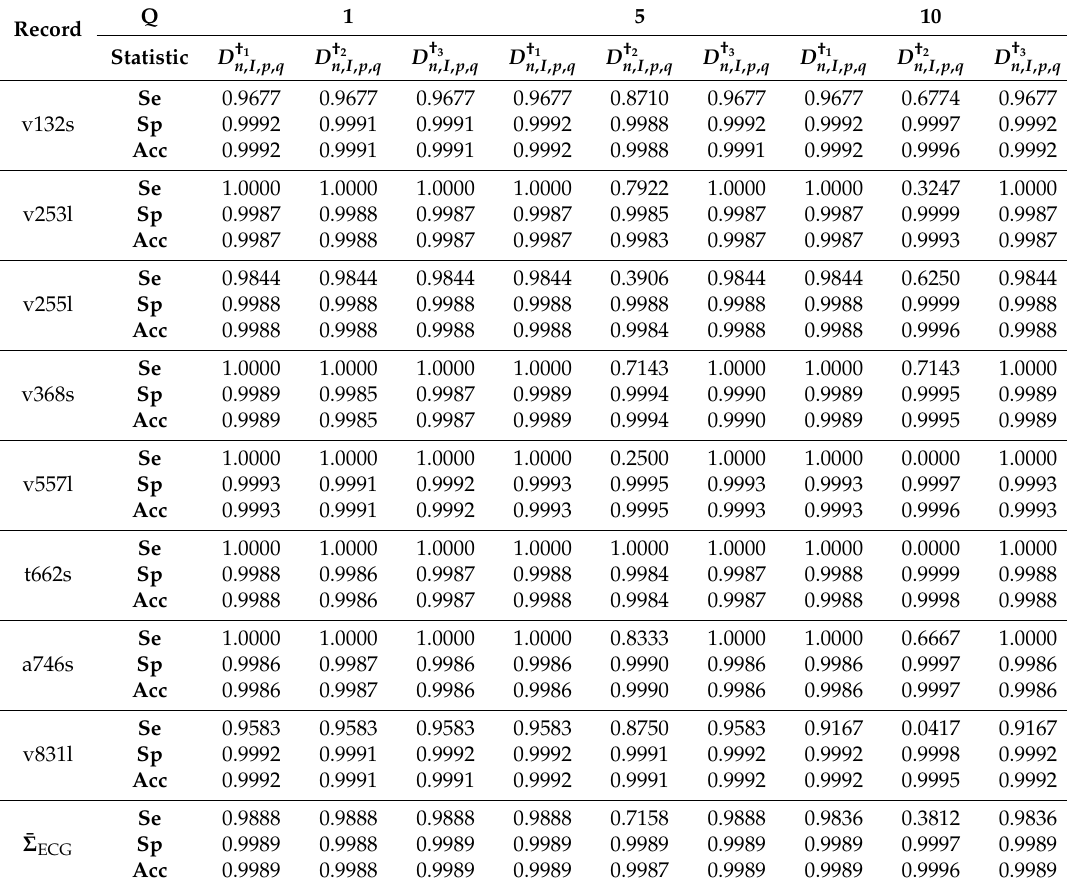
Table 1. Detection performance of l-SSA-CPD on PC15 ECG trace